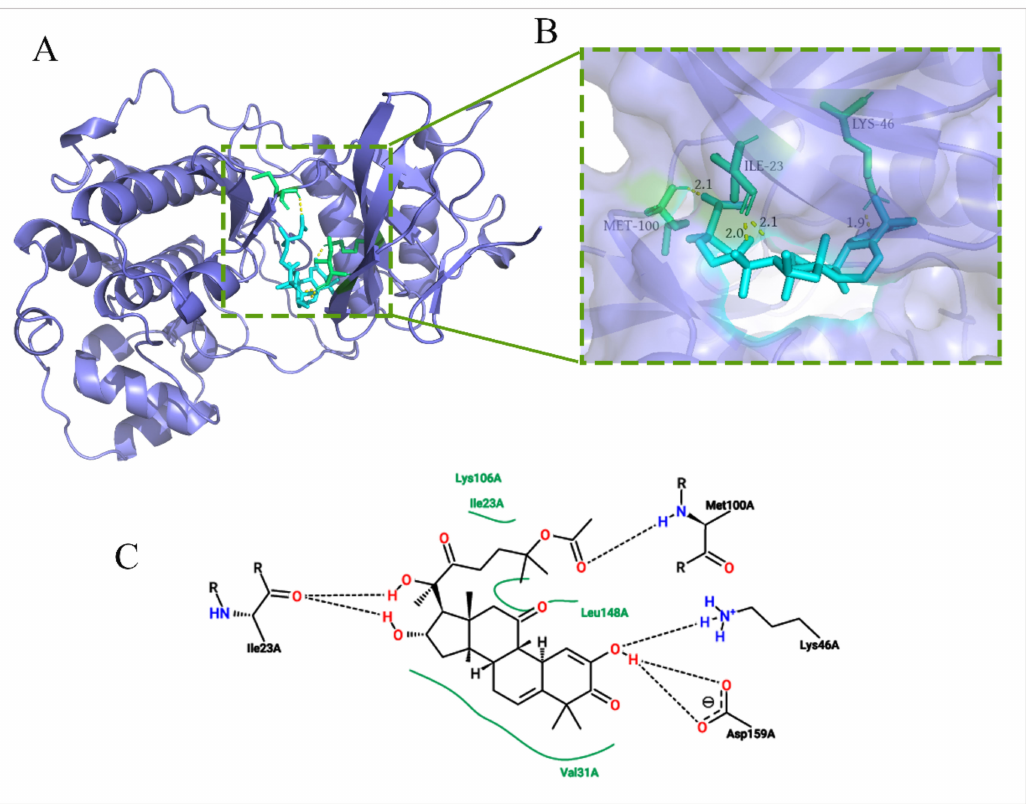
Figure 7. View of DHCE at the active site of ERK2. ( A ) Proposed binding mode of DHCE (in cyan) to the catalytic cleft of ERK2 (PDB ID: 5K4I). ( B ) Magnified view of DHCE interacting with residues around ERK2. ( C ) Two-dimensional diagrams for DHCE-ERK2 interactions generated from 3D models using the online tool Proteins Plus. Black dotted lines represent hydrogen bonds and the solid green lines represent hydrophobic